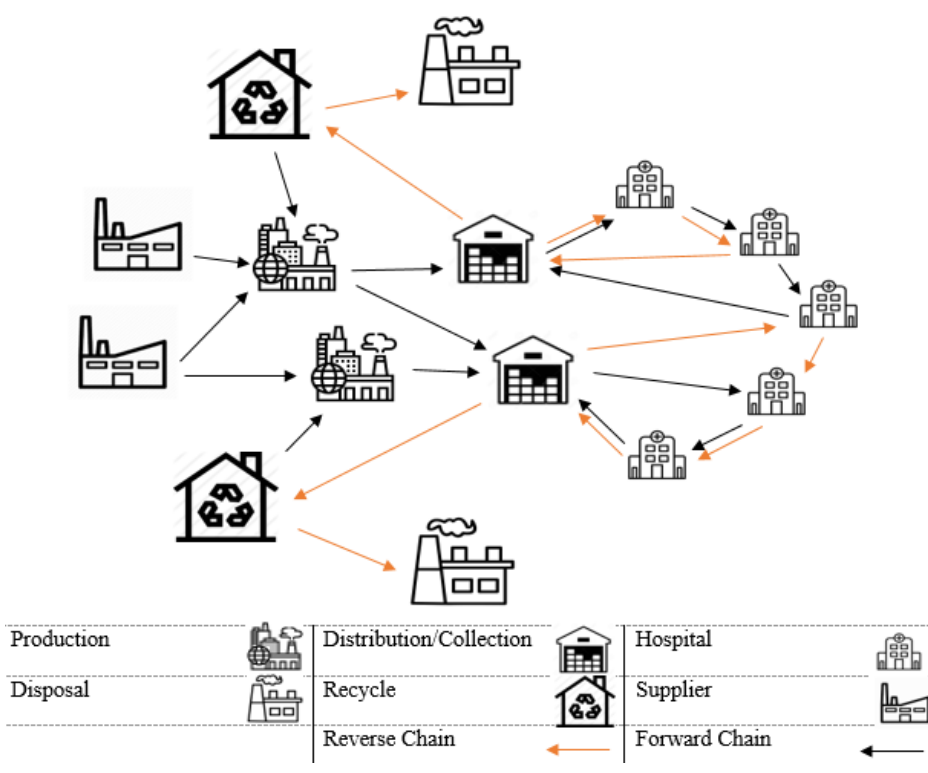
Figure 1. Proposed closed-loop supply chain network.